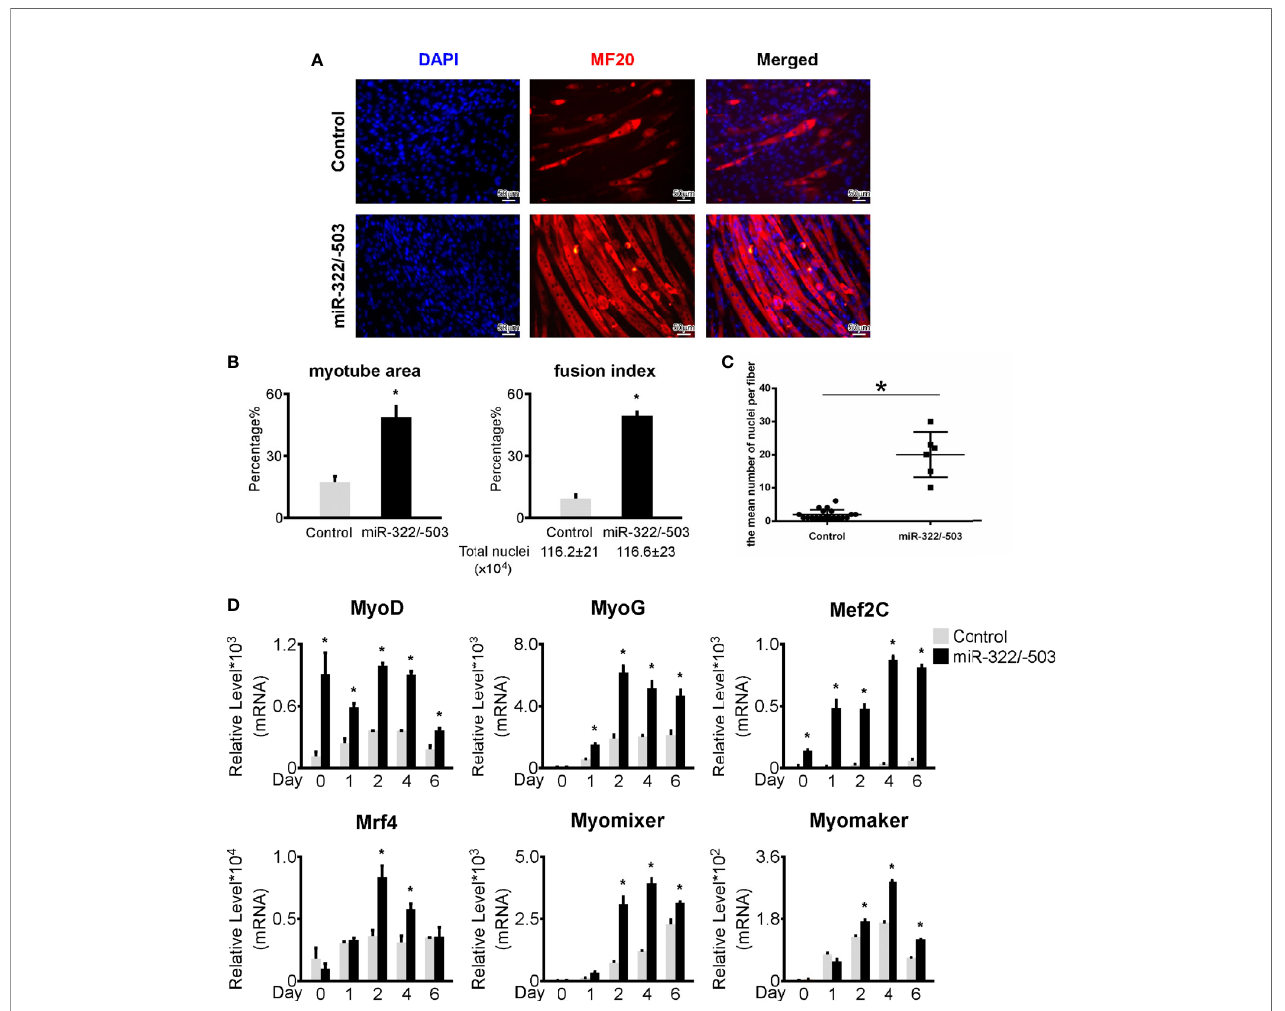
FIGURE 3 | miR-322/-503 rescued myoblast differentiation defects. (A) Ectopic miR-322/-503 expression improved myotube formation in DM1 myoblasts. Immuno fl uorescence staining against MF20 was performed on differentiation day 6. (B) The myotube area and fusion index were signi fi cantly increased with miR- 322/-503 overexpression. (C) The mean number of nuclei per fi ber was signi fi cantly increased with miR-322/-503 overexpression. (D) The expression of muscle regulatory factors (MyoD, MyoG, Mef2C, and Mrf4) and myoblast fusion genes (Myomixer and Myomaker) was signi fi cantly upregulated with miR-322/-503 overexpression. Control, control empty vector stably transfected DM1 myoblasts; miR-322/-503, miR-322/-503 overexpressing DM1 myoblasts; n ≥ 3; *, p <